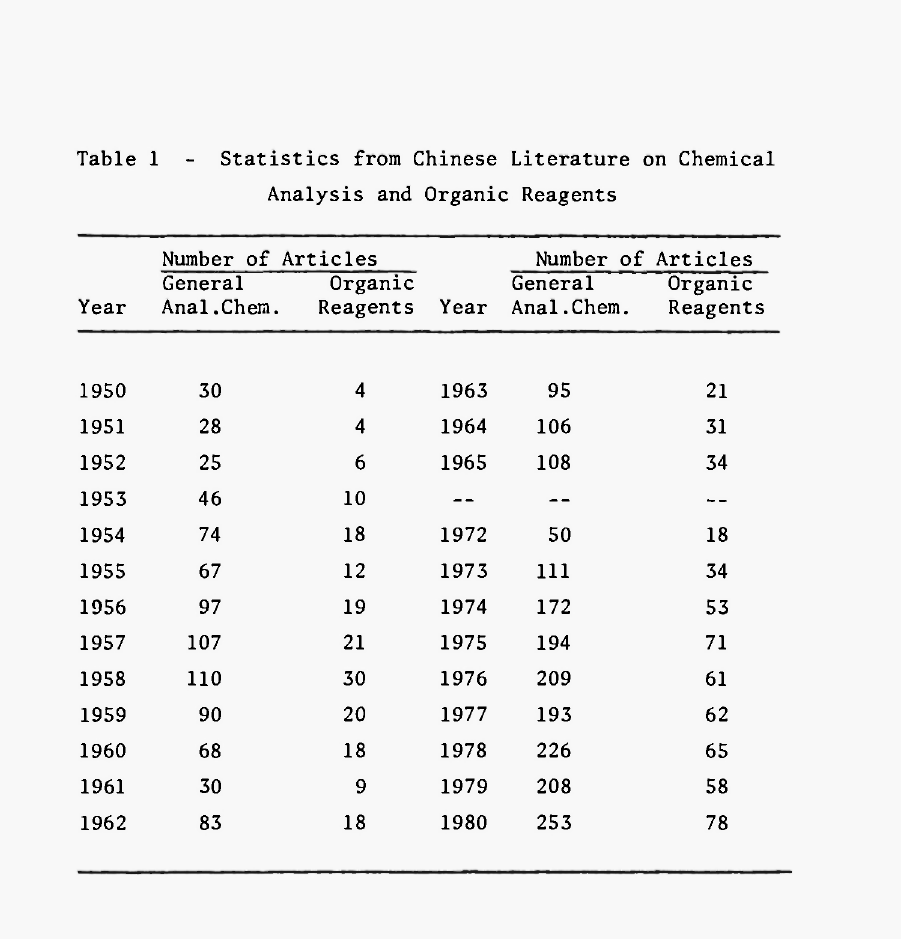
Table 1 - Statistics from Chinese Literature on Chemical Analysis and Organic